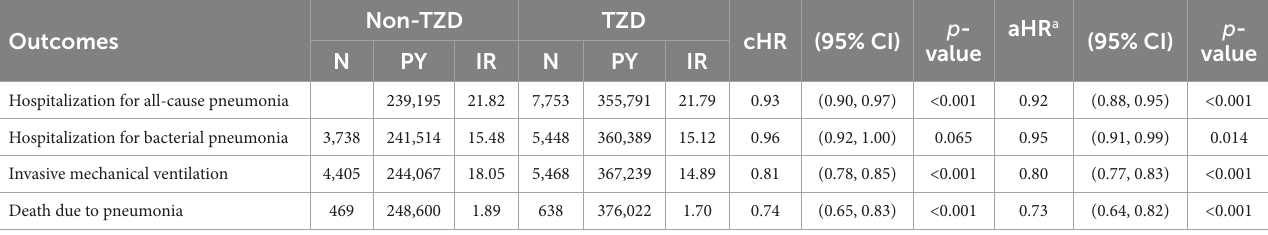
TABLE 2 Incidence rate and hazard ratio of main outcomes between TZD use and no-use in patients with T2D. Non-TZD Outcomes